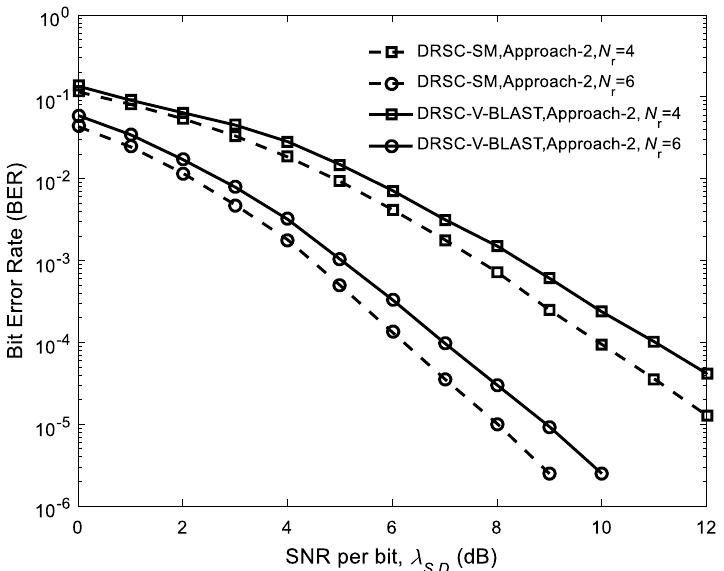
Fig. 19 Performance comparison between the DRSC-SM and DRSC-V-BLAST schemes with RS 1 ( 15,13 ) and RS 2 ( 15,7 ) . The dashed line with square mark demonstrates the BER performance of DRSC-SM scheme under N r = 4 . The dashed line with circle mark demonstrates the BER performance of DRSC-SM scheme under N r = 6 . The solid line with square mark demonstrates the BER performance of DRSC-V-BLAST scheme under N r = 4 . The solid line with circle mark demonstrates the BER performance of DRSC-V-BLAST scheme under N r =